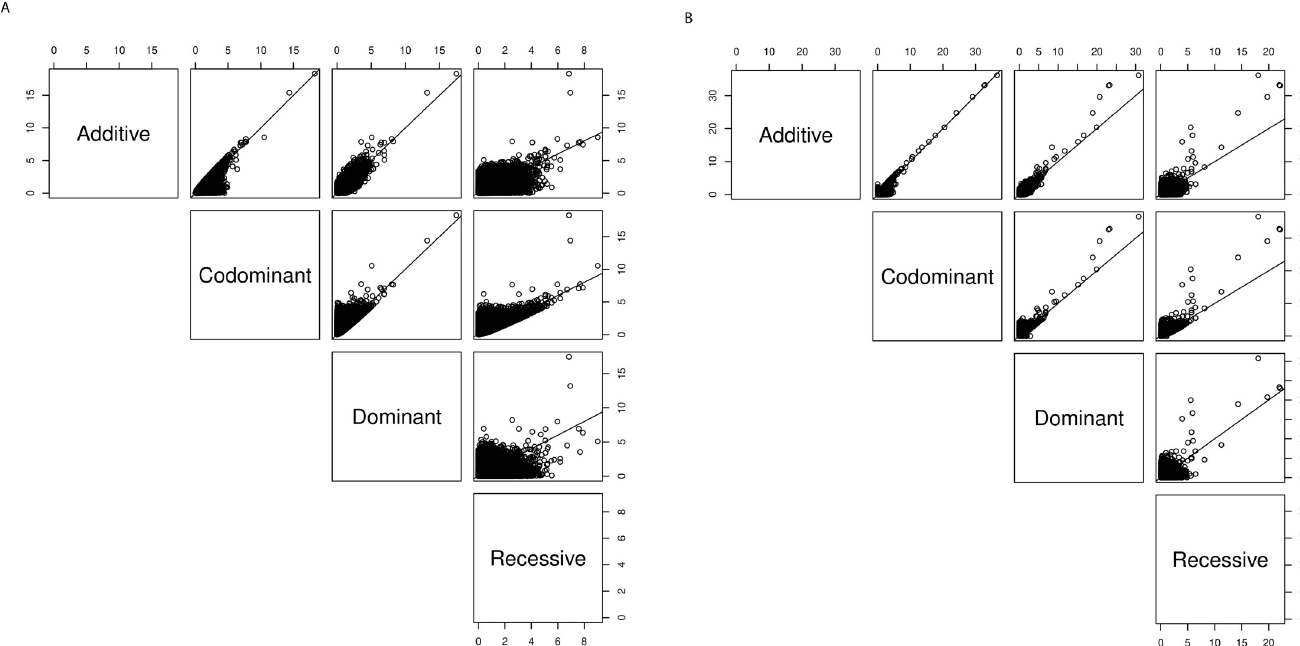
Fig 9. Pairwise comparisons of the -log10 p-values for the multi-encoding GWAS of (A) T2D and (B) AMD. For each SNP, we plotted the -log10 p-values for pairwise combination of encodings in six scatterplots for (A) T2D and (B) AMD compared to the identity line (1:1 line) such that pairs of encodings having p-values that fall closer to the line are more